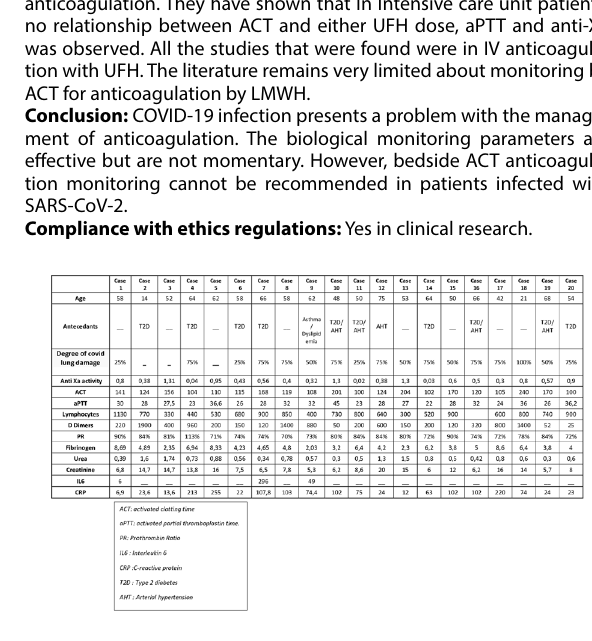
Table 1: Clinico-biological and radiological parameters of our